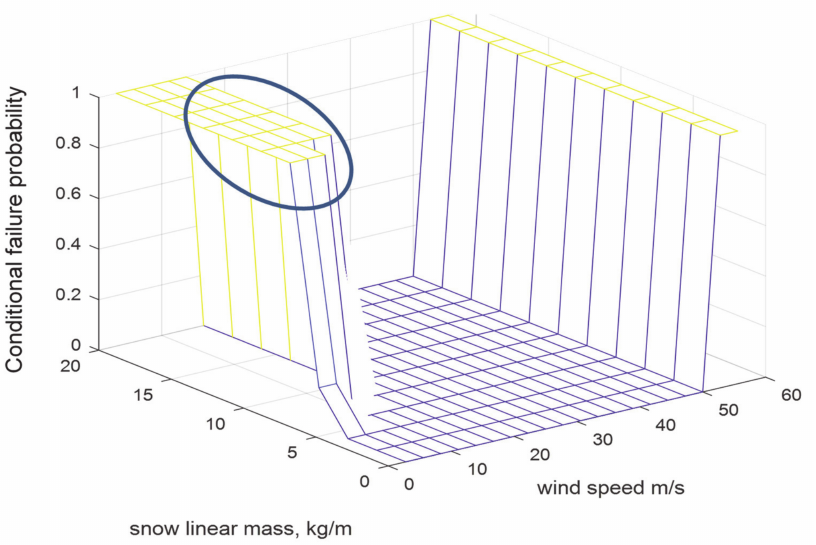
Figure 1. Vulnerability curves of the subcomponents for a line span, as a function of the linear wet snow mass and wind speed